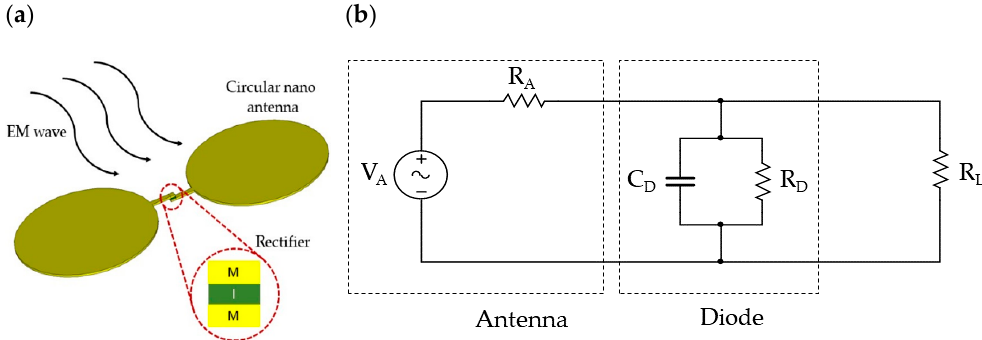
Figure 1. ( a ) Schematic of a rectenna device and ( b ) its equivalent circuit. For efficient terahertz rectification, low diode capacitance and dynamic resistance are